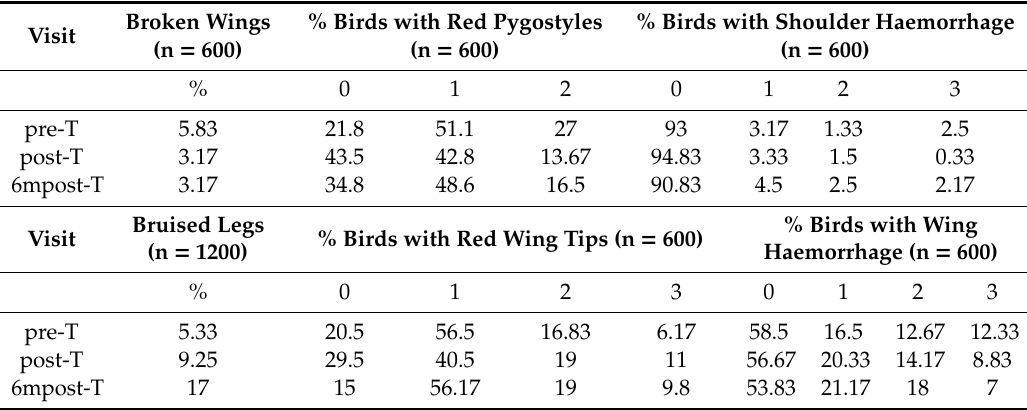
Table 4. The percentage of birds in each visit to processing plant P1 with broken wings, bruised legs and within each external carcass quality class (0–2 or 0–3). Class 0 indicates no visible damage and class 1 indicates a low level of damage which will not result in downgrading while classes 2 and 3 indicate damage which will result in carcass downgrading [15].